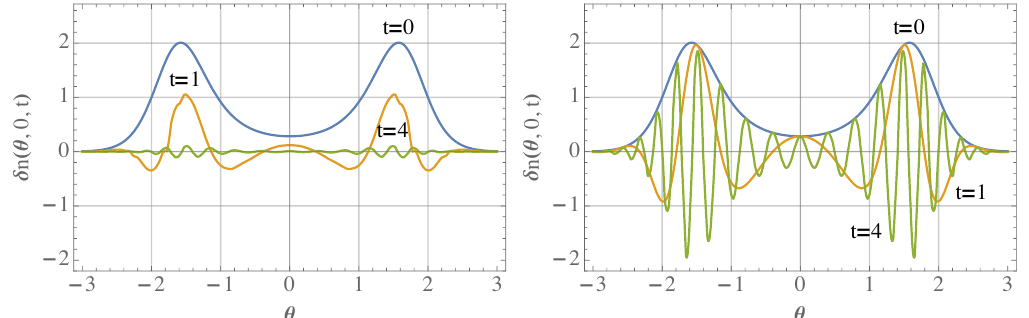
( θ ,0, t ) with (left panel) k